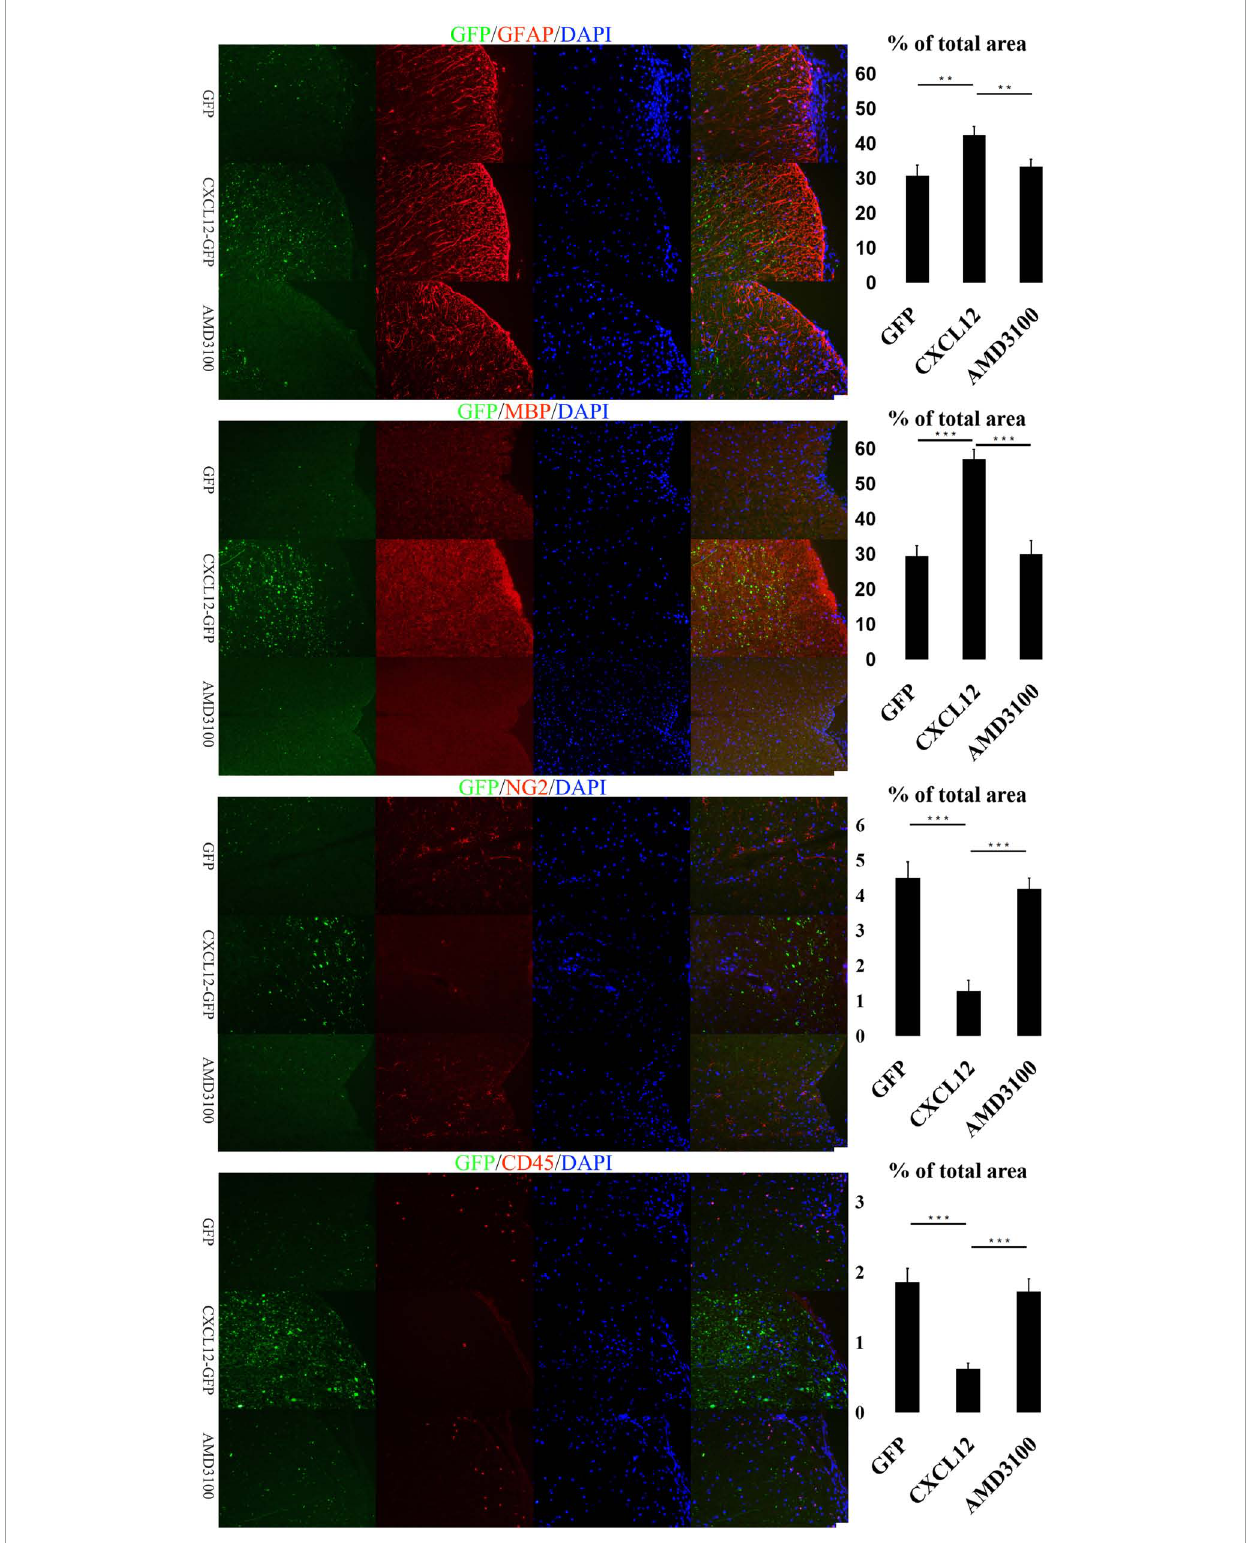
FIGURE4 Upregulation of CXCL12 alleviated the spinal cord aberrations of experimental autoimmune encephalomyelitis (EAE) at the peak stage. At the peak stage of EAE, the significant differences in the glial fibrillary acidic protein (GFAP) and myelin basic protein (MBP) signals between the three groups showed that there was severe demyelination in the eGFP group and CXCL12-AMD3100 group. There were also significant differences in the CD45 and NG2 signals, suggesting that leukocyte infiltration likely led to deterioration of demyelination and that oligodendrocyte precursor cells (OPCs) were actively involved in remyelination. Data presented as the mean ± SEM. “*” represents value of P < 0.05, “**” represents value of P < 0.01, “***” represents value of P < 0.001 by two-tailed Student’s t -test or one-way ANOVA, n = 4–6 rats. The bar in the lower right represents 50 µ